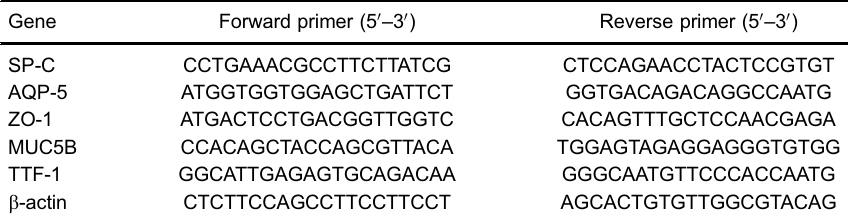
Table 1. Sequences of primer sets used in this